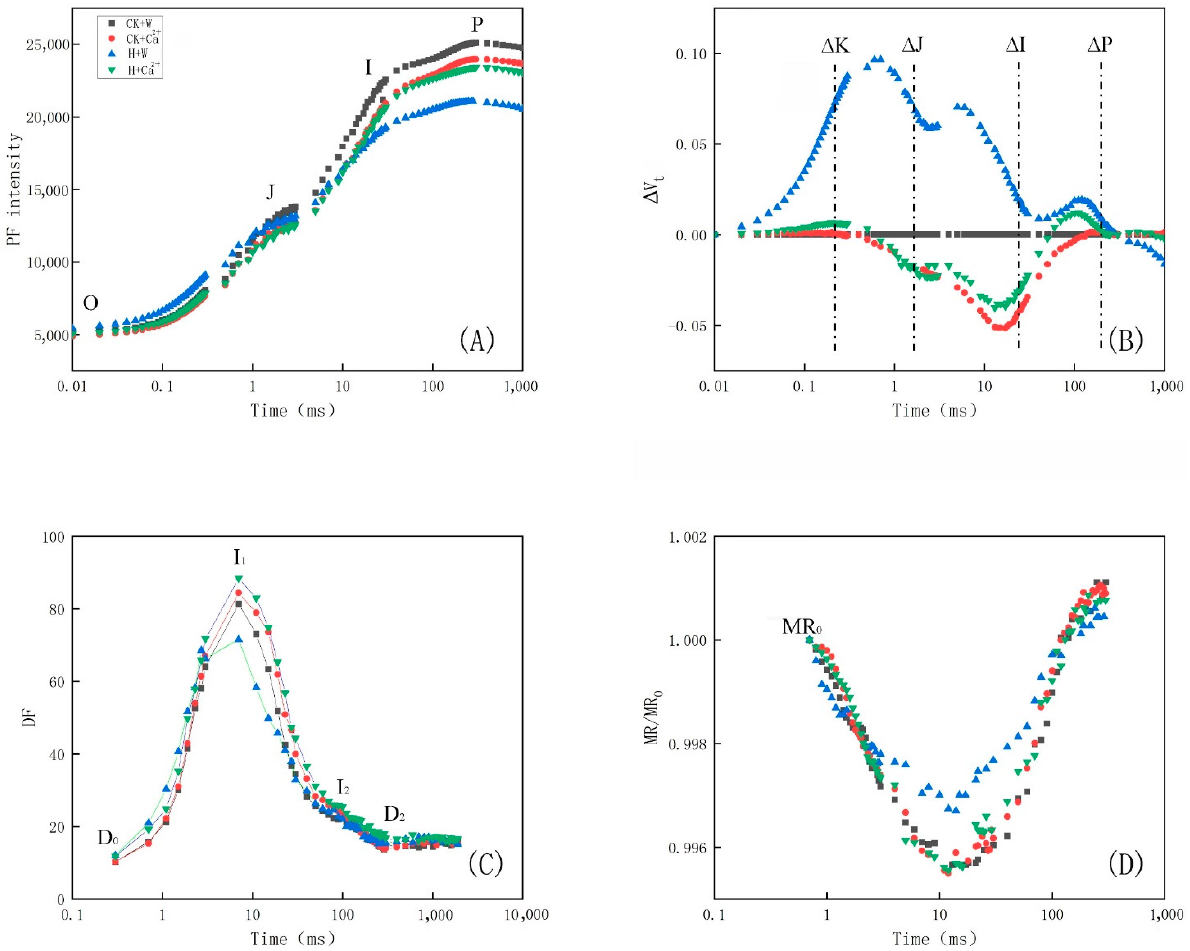
Figure 4. PF, DF, and MR kinetics in the leaves of Rhododendron × pulchrum under four treatments. Each curve is the average of three replicates. ( A ) Prompt chlorophyll a fluorescence (PF). The signals were plotted on a logarithmic time scale. The signals were fluorescence intensity at 20 µ s ≡ F O , 3 ms ≡ F J , and 30 ms ≡ F I ; maximum fluorescence intensity, F P = F M . ( B ) Effect of the development of PSII on the relative variable fluorescence [ ∆ Vt = (F t − F 0 )/F v − V t (CK + W) ]; for ∆ Vt analysis, the fluorescence of the leaves of the control treatment with distilled water (CK + W) was used as the reference and equaled 0. ( C ) Delayed chlorophyll a fluorescence (DF). The signals were plotted on a logarithmic time scale. ( D ) Modulated 820 nm reflection (MR/MR O ). The signals were plotted on a logarithmic time